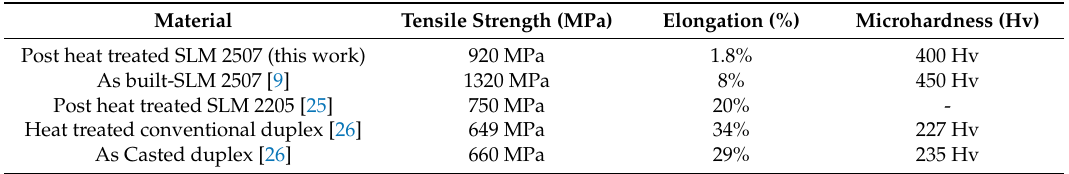
Figure 1. ( a ) Room temperature tensile test curve of post heat treated SLM 2507. ( b , c ) Fractography at different magnifications taken from the sample and Energy-dispersive X-ray spectroscopy (EDS) taken from ( c ) where the percentage of Cr and Mo representing the presence of intermetallic sigma phase is shown in EDS data Table in ( d ). Table 1. Room temperature mechanical properties of selective laser melted (SLM) duplex post heat treated at 1200 °C and as-built SLM and as-casted duplex stainless steel.